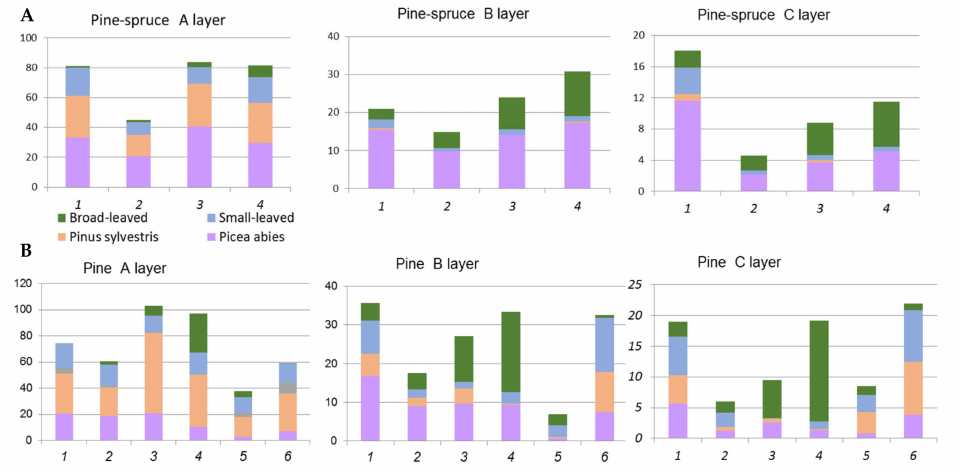
Figure 6. Changes in the activity of tree species in different layers of pine-spruce ( A ) and pine ( B ) communities. Association groups: 1—DshShG; 2—Sh; 3—ShBh; 4—Bh; 5—Mh; 6—DshHSh. X axis—number of association groups, Y